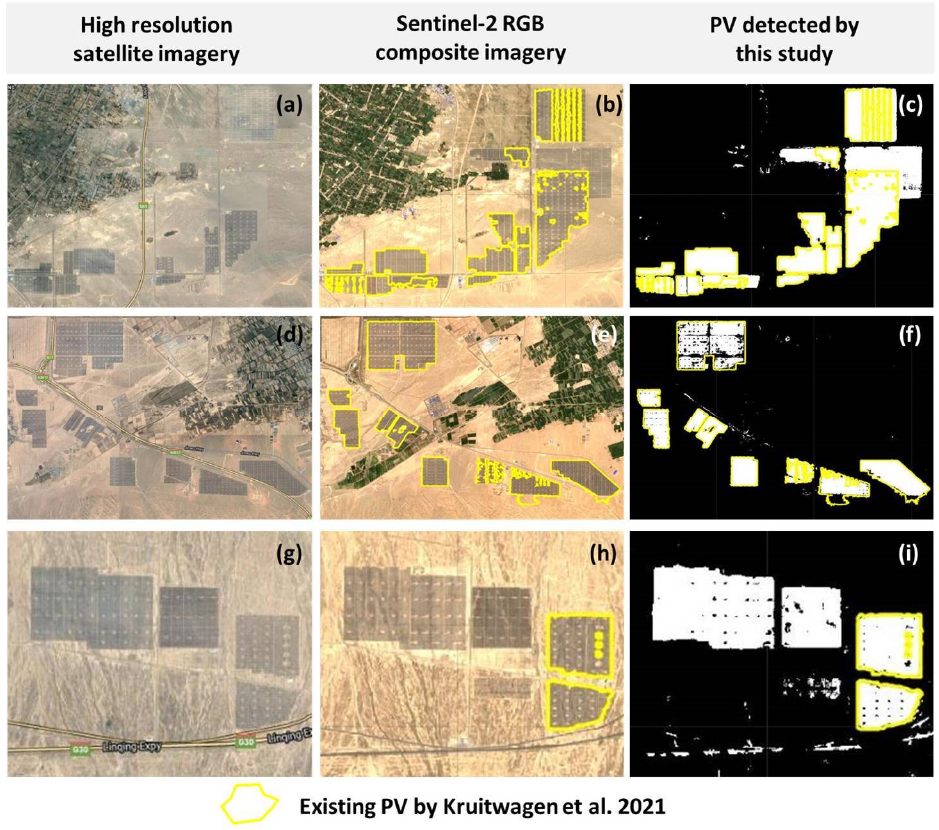
Figure 8. Classification results of PV stations in Gansu Province ( a – c ) 98.98°E, 39.97°N; ( d – f ) 102.37°E, 38.49°N; ( g – i ) 99.57°E, 39.29°N [12].